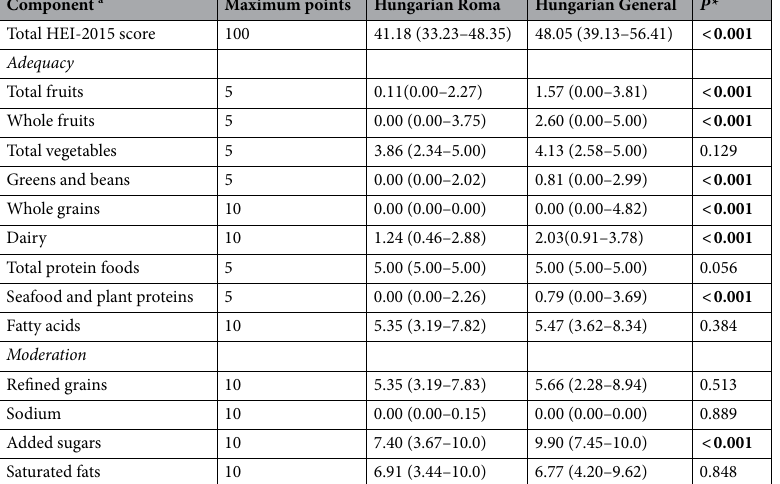
Table 3. Average Healthy Eating Index-2015 1 scores for Hungarian Roma and general samples. 1 The HEI-2015 is a measure of diet quality and includes 13 components that capture the balance among food groups including those to encourage (adequacy components) and those for which there are limits (moderation components). Higher scores of adequacy components reflect higher intakes that meet the standards. Higher scores of moderation components indicate lower intakes that are more desirable. Intakes between the minimum and maximum standards are scored proportionately. a Values are medians (25th-75th percentiles). Median values of components may not add up to median total HEI scores. *Differences in median scores were evaluated by Independent-Samples Mann–Whitney U test. Bold values represent significant differences.